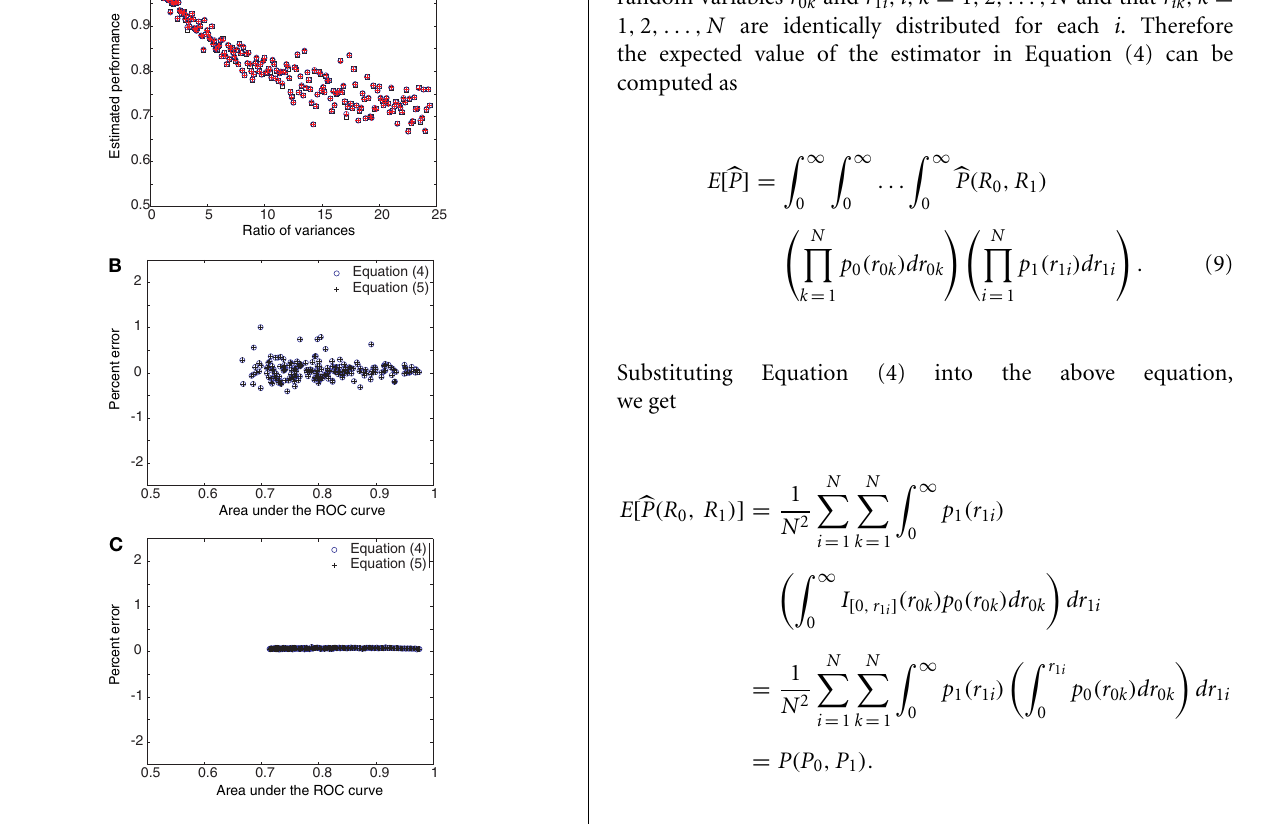
FIGURE 2 | Derived estimators and area under ROC curve as a function of variances. (A) Single estimates of the area under the ROC curve and Equations (4) and (5) are compared for progressively increasing ratio of variances for Gaussian distributions. The points are predominantly coincident. (B) The percent error for single estimates lies within 2%. (C) When 100 such trial estimates are averaged together, the percent error falls close to